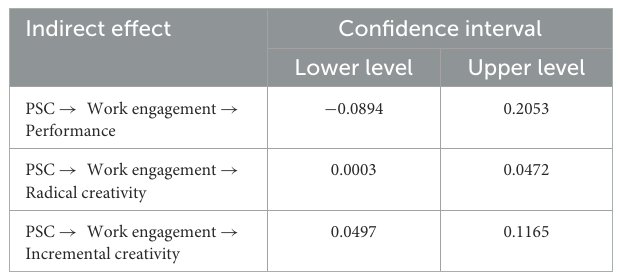
TABLE 6 Monte Carlo simulation results for the indirect